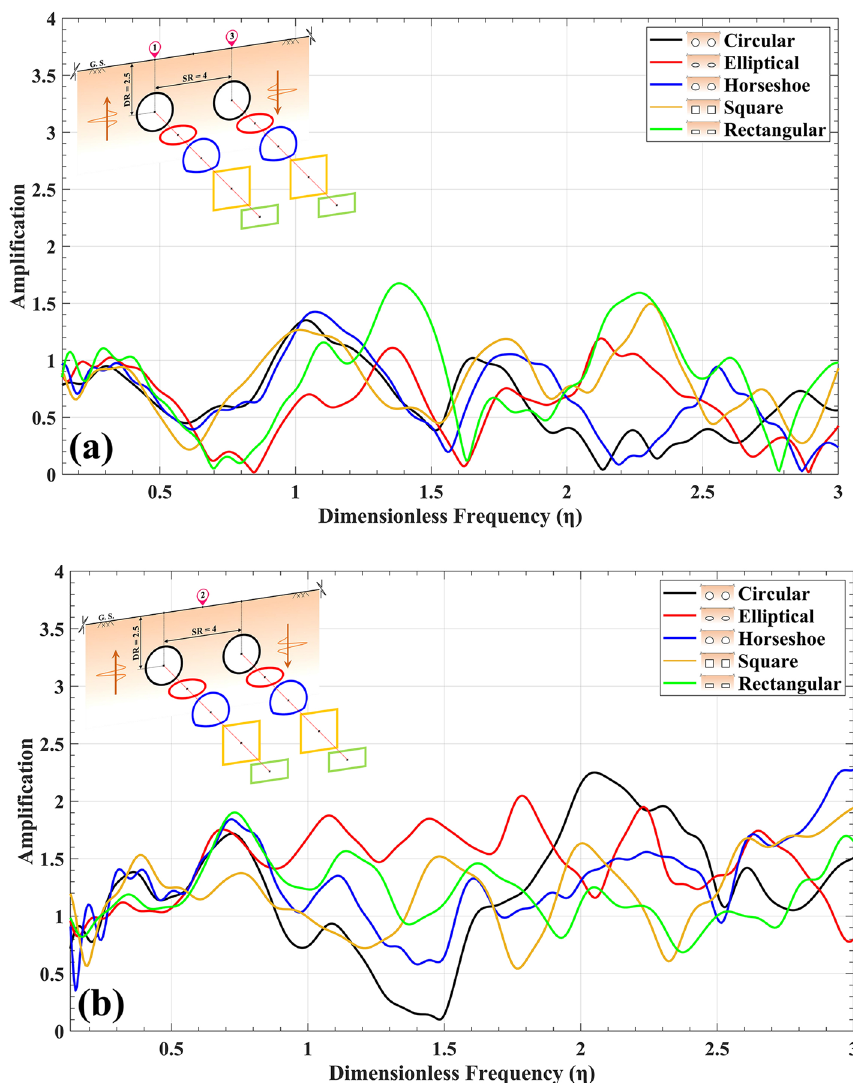
Fig. 13 The amplification of the ground surface versus dif- ferent dimensionless frequen- cies, for the model of twin lined tunnels with different geometries in a centerline of the tunnels, b central point subjected to the vertical inci- dent SH